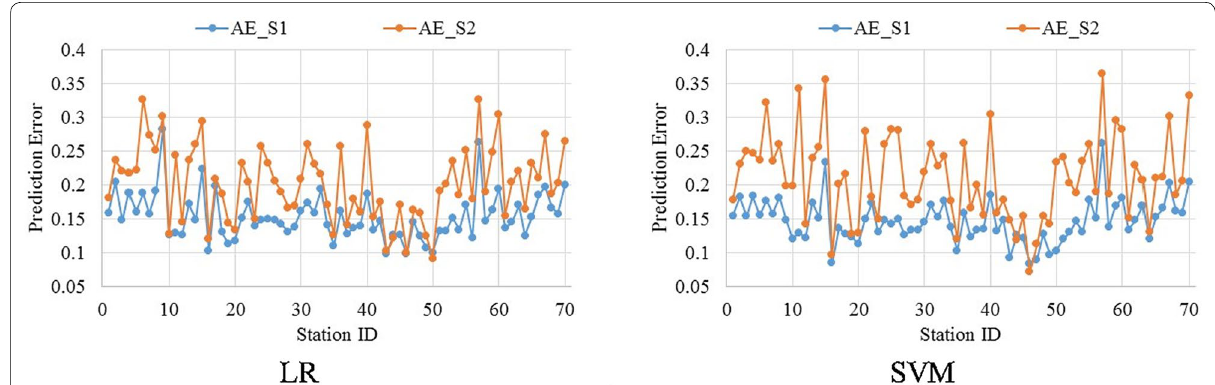
Fig. 5 Comparison of day-ahead prediction error between stage 1 and stage 2 AE features. Table 1 in appendix details the empirical results